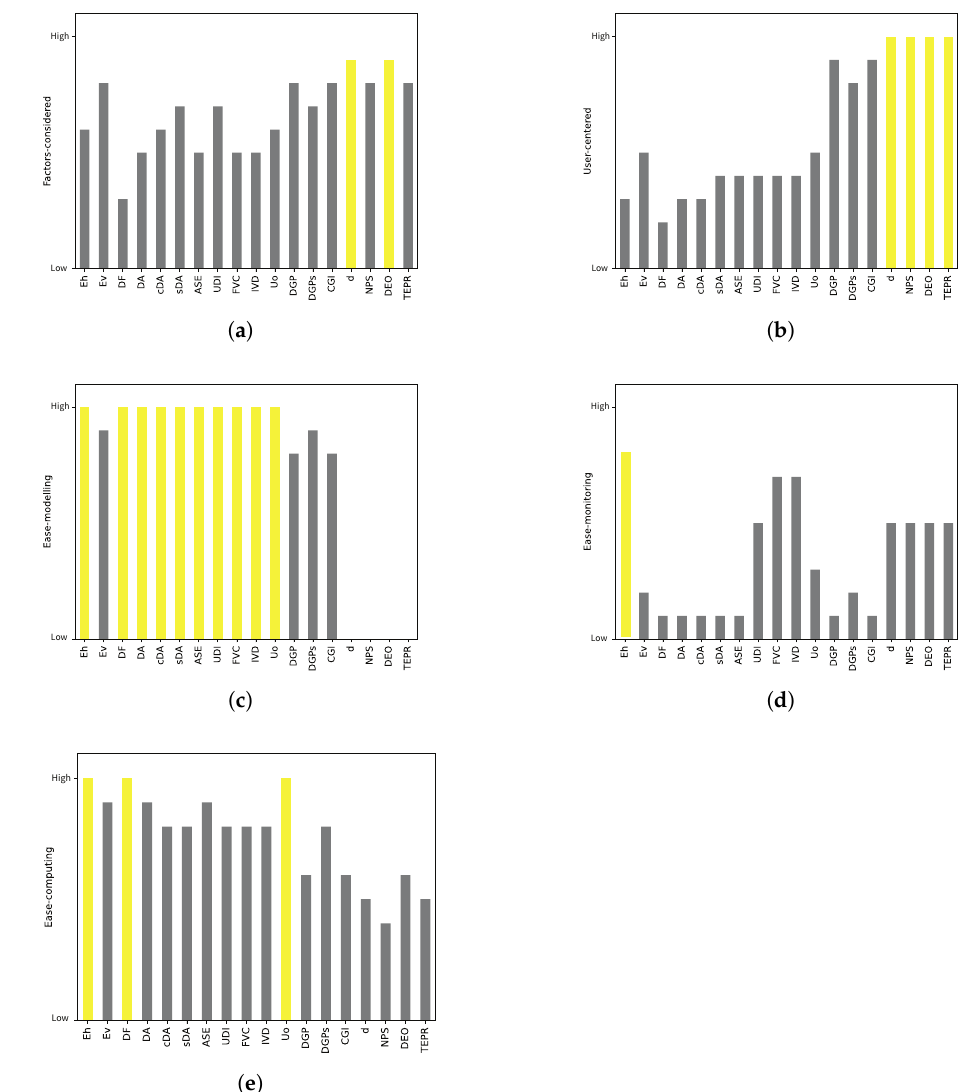
Figure 4. Direct comparison of the most utilized metrics under 5 different criteria, providing a subjec- tive and experience-based rating, and highlighting in yellow the highest ranked in: ( a ) completeness of relevant factors considered ( b ) degree of occupant-centred approach ( c ) ease of modelling in the design phase ( d ) ease of monitoring in the operation phase ( e ) ease of